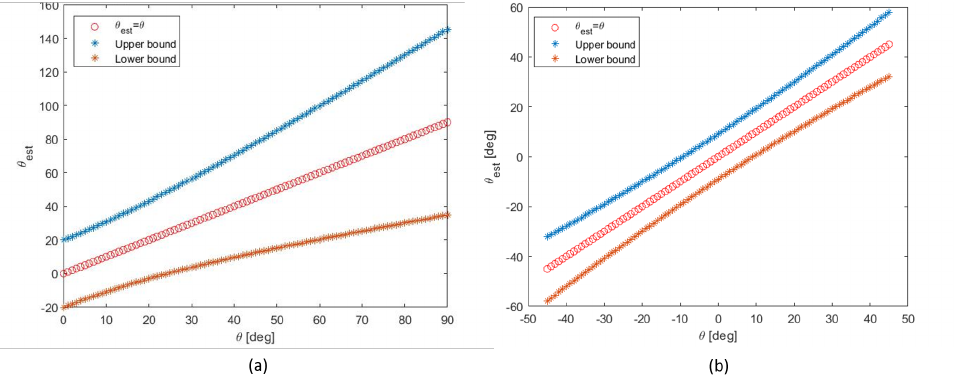
Figure 2. Upper and lower error bounds of two clusters of three shaped sensors to estimate the direction of arrival (DoA), when the wave mode velocity is unknown: ( a ) the case of the cluster presented in [15]. ( b ) The new cluster of three shaped